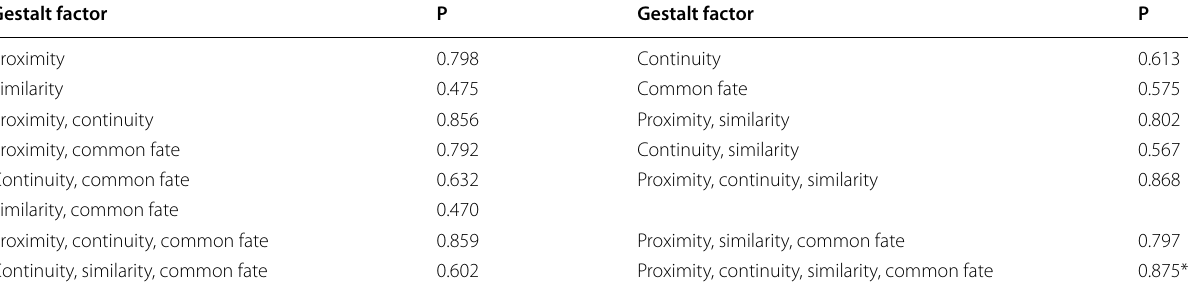
*The agreement degree is highest. Therefore, these gestalt factors are used in proposed system